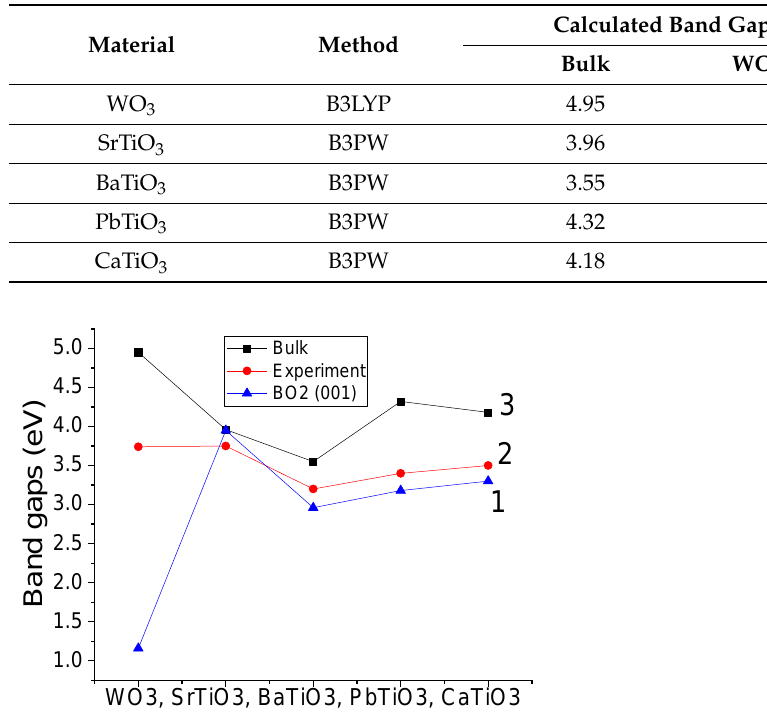
Figure 5. Our ab initio-calculated WO 2 -terminated WO 3 and TiO 2 -terminated SrTiO 3 , BaTiO 3 , PbTiO 3 and CaTiO 3 (001) surface Γ – Γ band gaps (line 1). Experimentally measured bulk Γ – Γ band gaps (line 2). Our ab initio-calculated WO 3 , SrTiO 3 , BaTiO 3 , PbTiO 3 and CaTiO 3 bulk Γ – Γ band gaps (line 3).